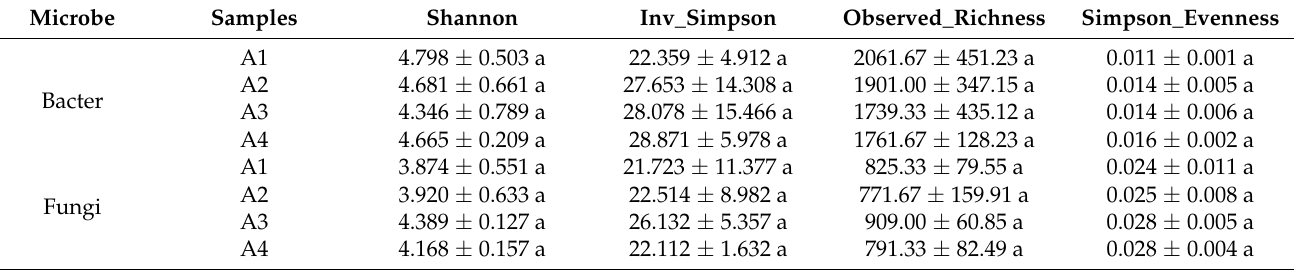
Table 4. Sample α diversity index.